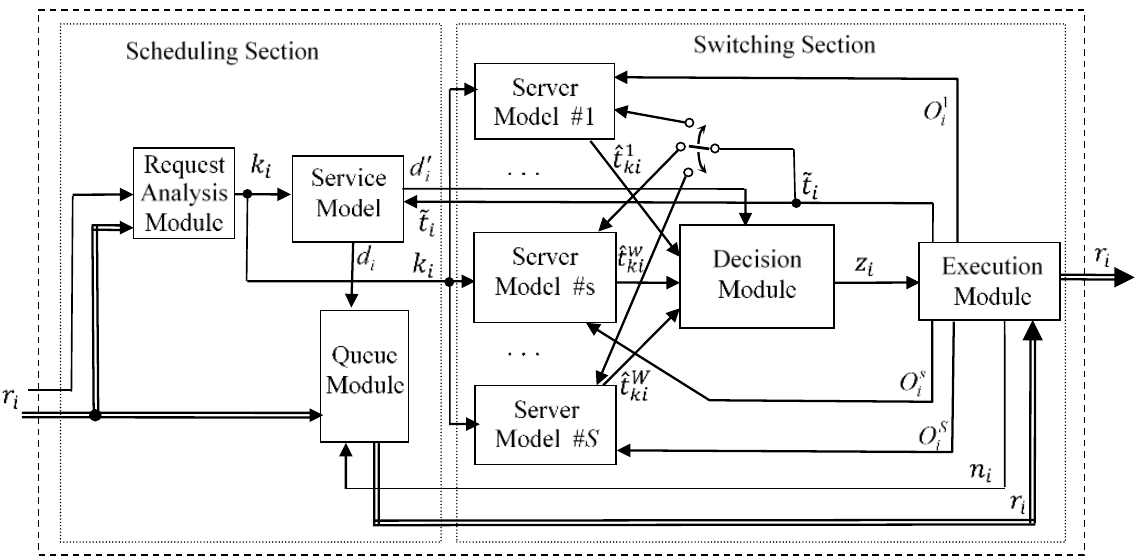
Figure 2. Web Cloud Earliest Deadline First (WCEDF) web switch design.